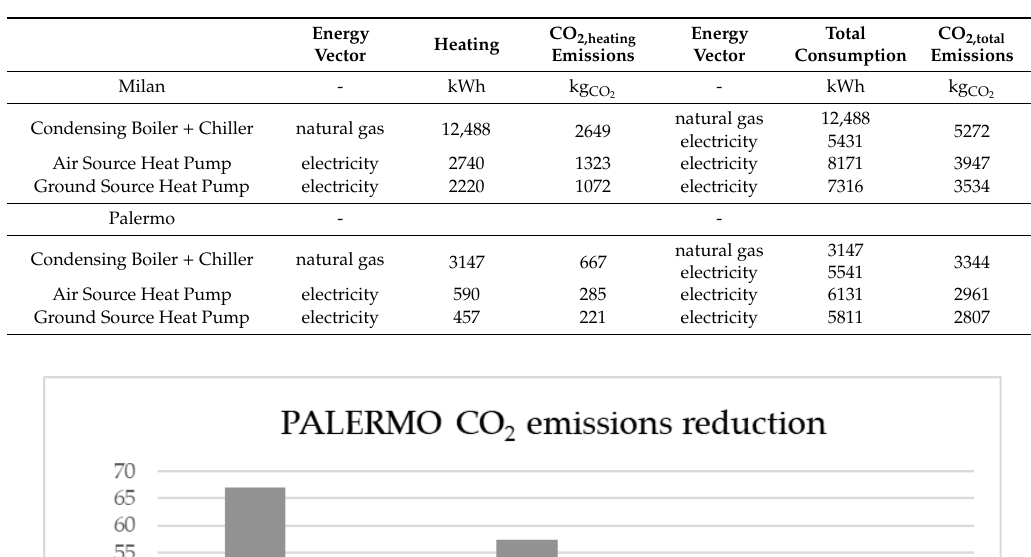
Table 6. Annual CO 2 emissions for Milan and Palermo referred to only heating and global energy consumption.